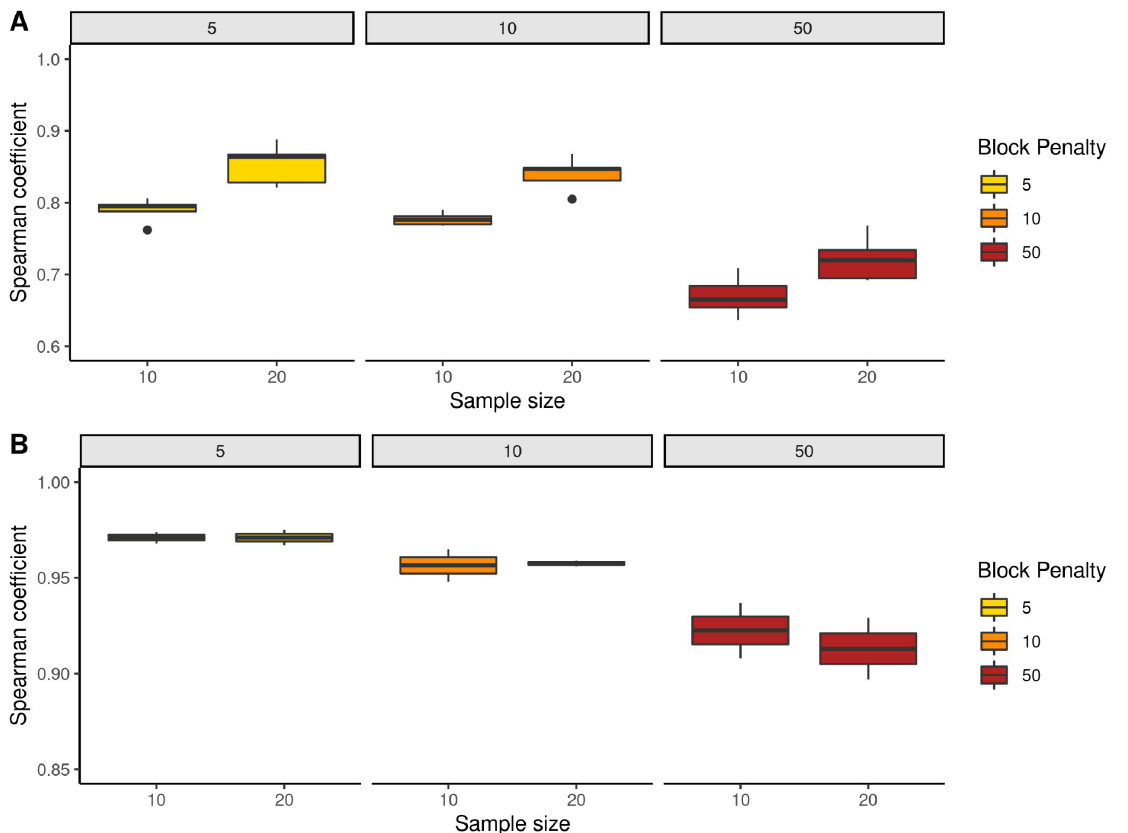
share a smaller fraction of them, due to the additional inference step.